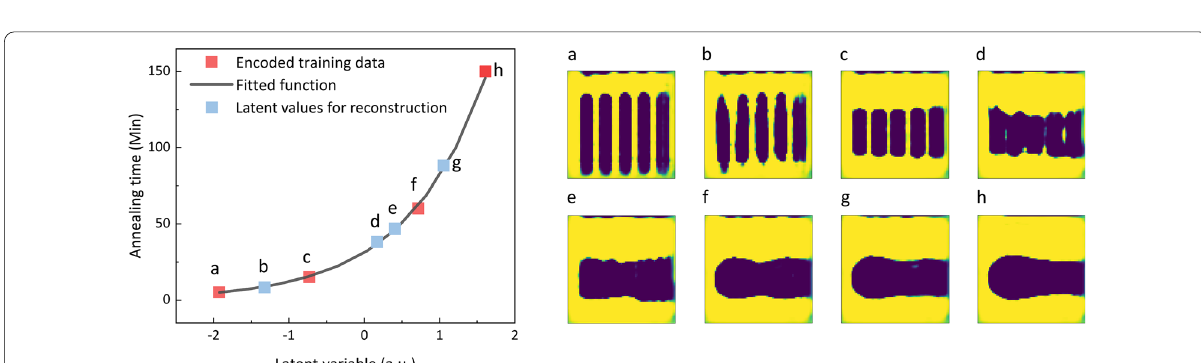
Fig. 5 Simulated sub-surface morphology from the subsequent reconstruction training. Cross-sectional images of sub-surface morphology are simulated based on the same four times: 5, 15, 60, and 150 min, denoted as red boxes ( a , c , f , h ). From their exponential fitting between latent value and annealing time, four latent values denoted by blue squares are for their reconstructions ( b , d , e , g